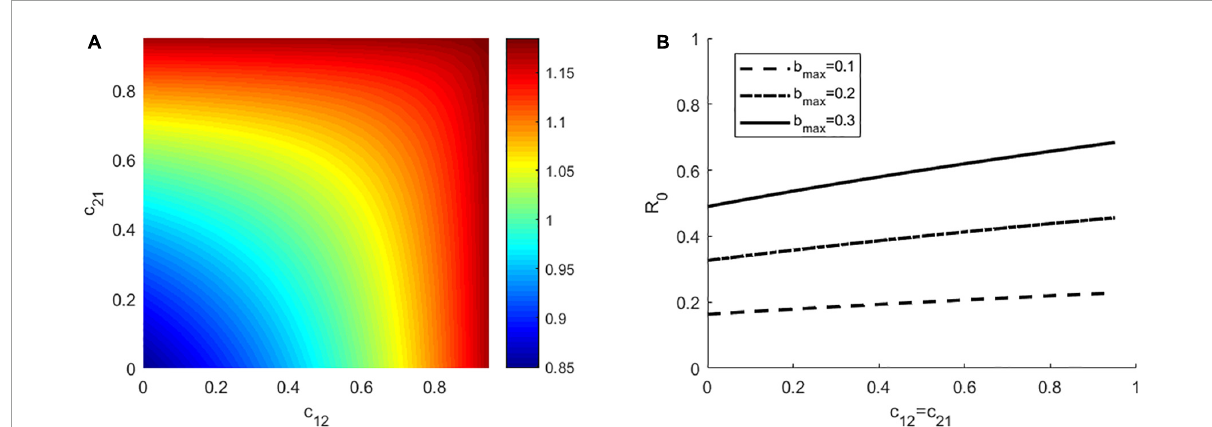
FIGURE1 (A) The effect of interspecific competition on R 0 . (B) The effect of interspecific competition (only for c 12 = c 21 ) on R 0 at three different values of b max = 0.1, 0.2, 0.3, respectively. In panel (A) , b max = 0.3, the other parameters in the two panels have the same values as: α = 1, γ = 1, K